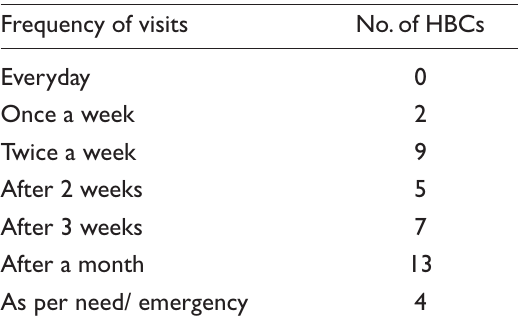
Table 4. Frequency of Visits to Children on ART by